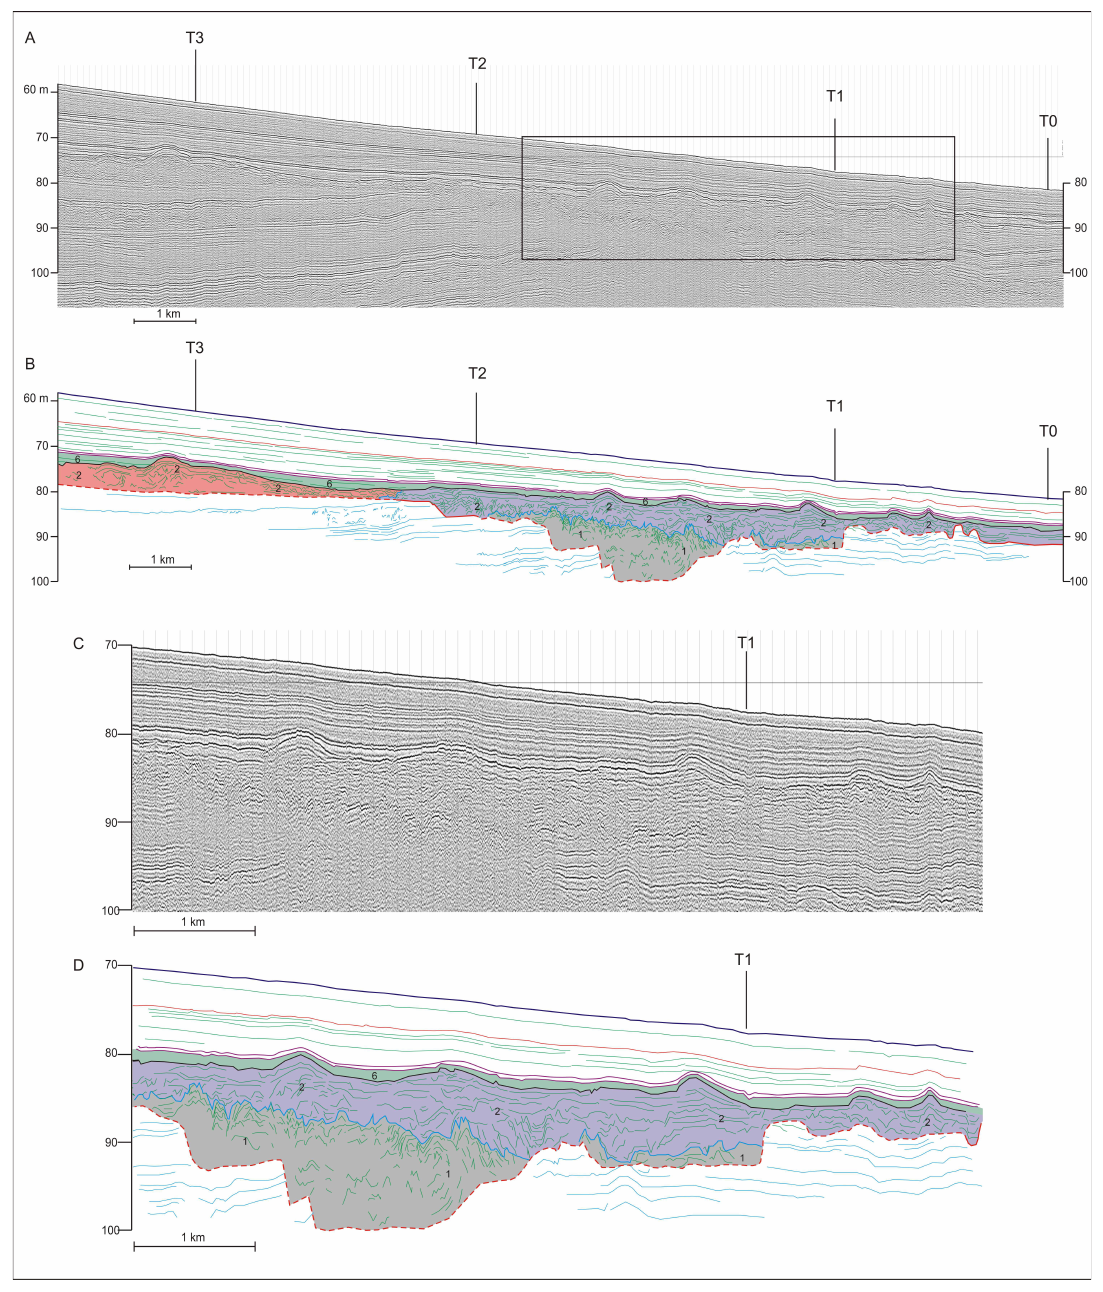
Figure 6. Part of seismic profile P7. Seismic section ( A ) and interpretation ( B ) showing, among others, the transversal section of the distal part of the Ofanto valley (OV), filled by unit BU1 l , and unit A l . ( C , D ) report an enlargement and its interpretation of the seismic profile sector included in the rectangle reported in ( A ). Note, within unit A l, the well-defined alignment, intercepted longitudinally by this profile, of the sedimentary body formed by seismic facies 2, topped by an irregular surface modelled into a dune-like / barrier